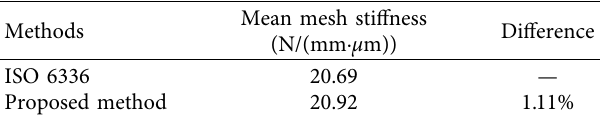
Table 2: Comparison of mesh stiffness obtained from different methods.